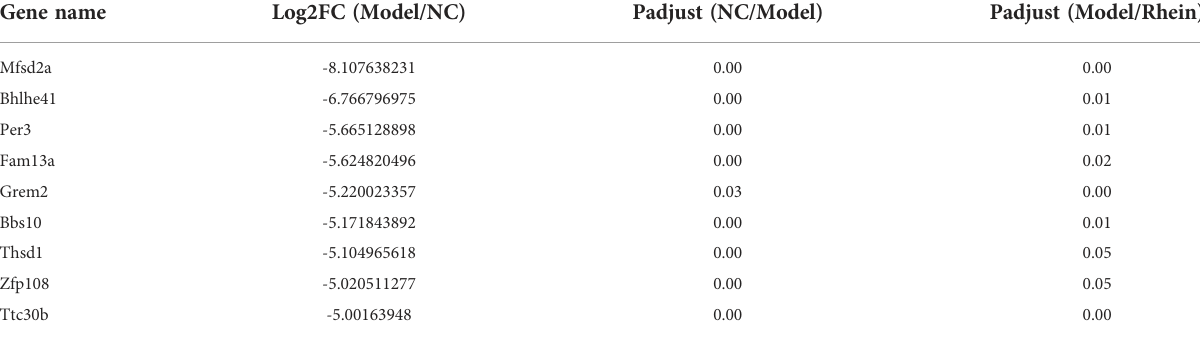
TABLE 1 Signi fi cantly down- regulated genes (-5<Log2FC<5, Padjust<0.05) upon exposure of D-DalN/LPS compared to the control